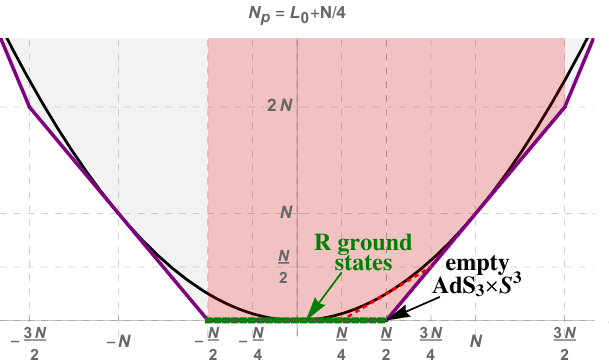
Figure 1 . The J - N p plane of the 3-charge system in the R sector. The states exist only on and above the unitarity bound represented by the purple polygon. The single-center BMPV black hole exists only above the parabola N p = J 2 (sometimes called the cosmic censorship bound) (black curve). The empty AdS 3 (cid:2) S 3 correspond to the point ( J; N p ) = ( N= 2 ; 0). R ground states live on the green dotted line. The red dotted line represents de Boer’s bound (see section 5).